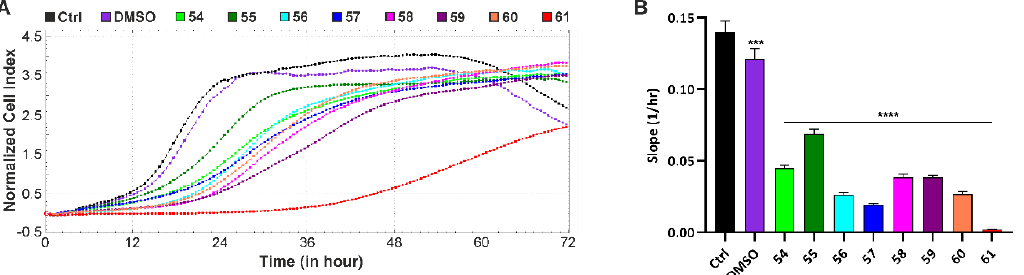
Figure 3. Real-time migration potential of HepG2 cells after 24 h administration of compounds 54 – 61 . The migration potential of the cells was monitored using the xCELLigence system. HepG2 cells were incubated with the analyzed compounds for 24 h before the analysis at the concentration corresponding to one-fourth of the IC 50 value. The impedance (cell index values) was measured every 30 min for the next 72 h. To eliminate the influence of the solvent, DMSO was added to the cells in a volume that corresponded to the highest compound concentration ( A ). The slope parameter represents the rate of changes in CI values of HepG2 cells within the first 24 h ( B ). Statistical significance is indicated by asterisks: (***) p < 0.001, and (****) p < 0.0001.